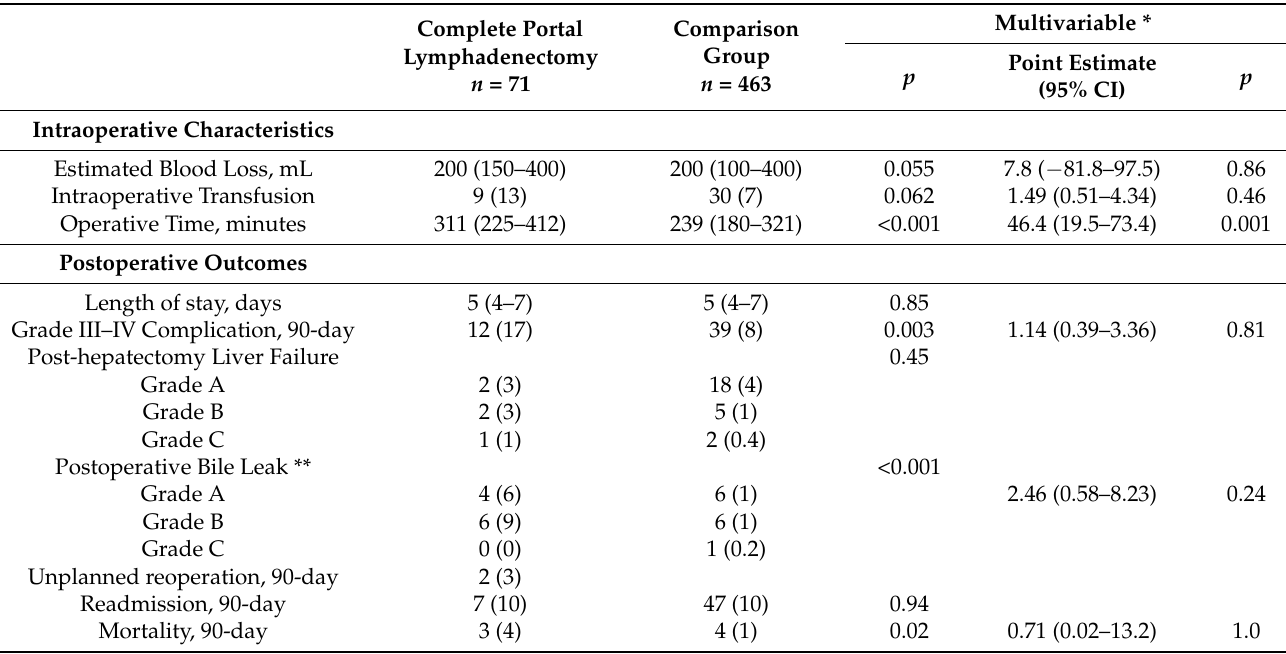
Table 2. Intraoperative and postoperative outcomes of